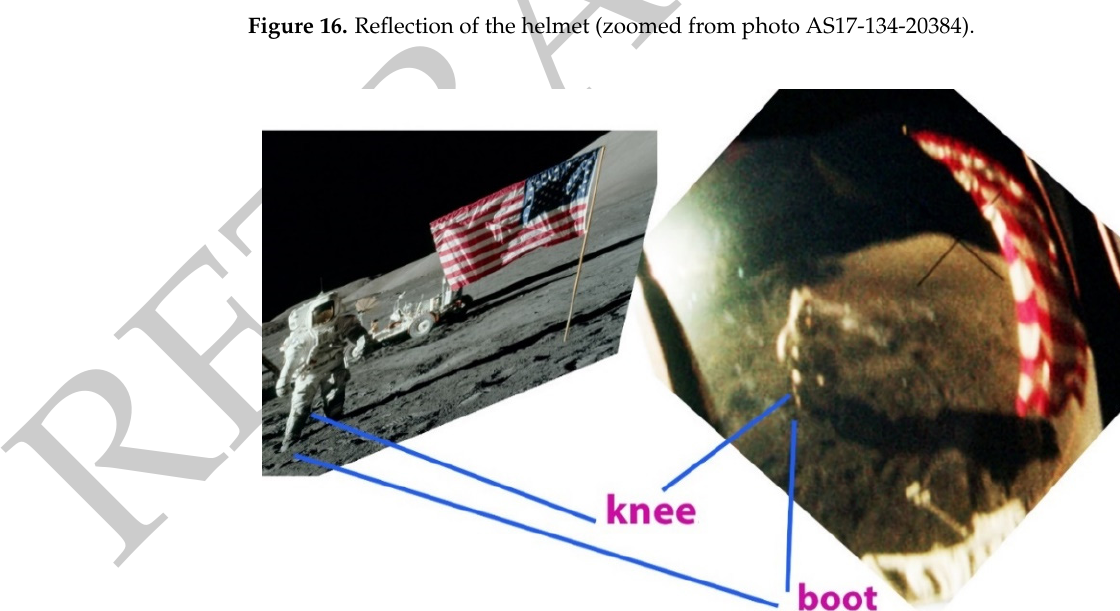
Figure 17. Comparison of astronaut imaged in photo AS17-134-20381HR (modified in “perspective wrapping” of Photoshop to match the view of the helmet) shows that the astronaut is standing, in conjunction with the indication of his shadow.